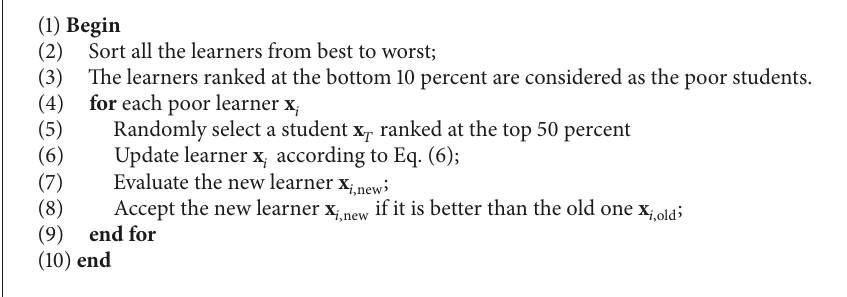
Algorithm 4: Poor student tutoring phase.